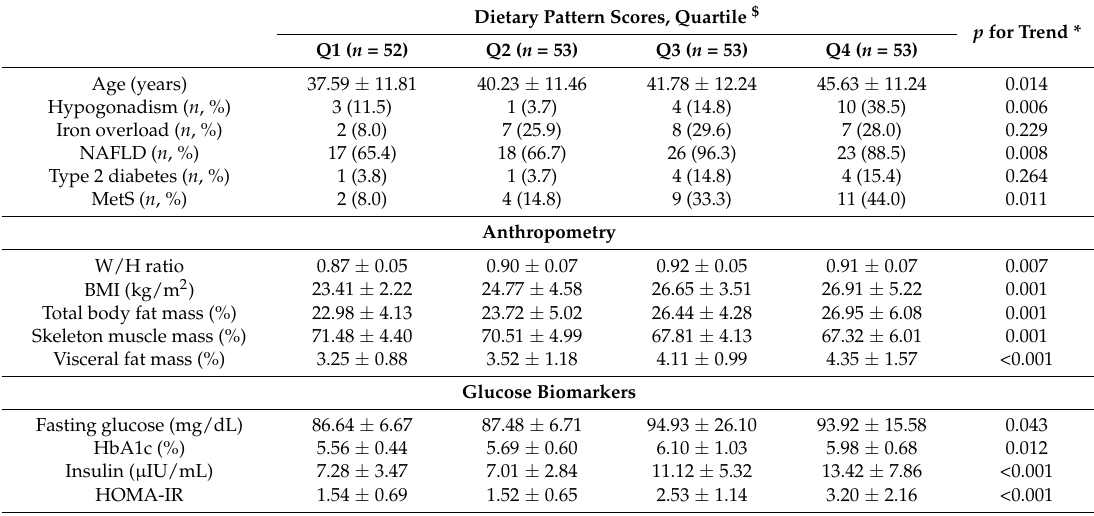
Table 4. Characteristics of the study population according to quartiles of dietary pattern scores. Dietary Pattern Scores, Quartile